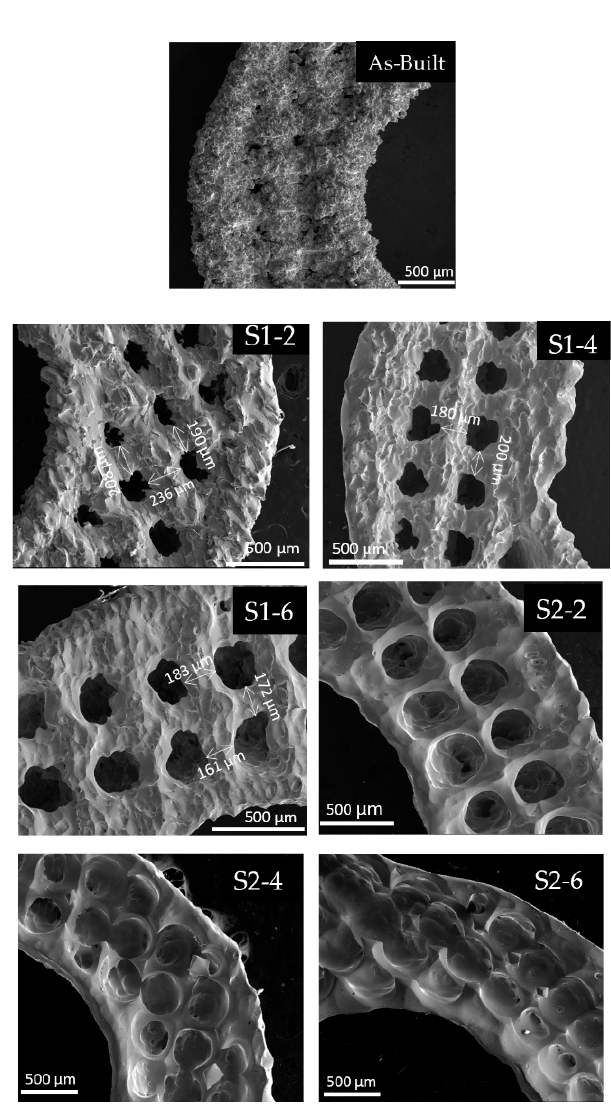
Figure 11. The SEM result of chemically polished porous plates under six different etching conditions.